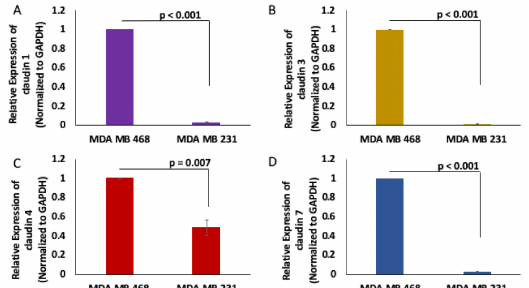
Figure 2. Claudins 1, 3, 4 and 7 expression in MDA MB 468 and MDA MB 231 cells. Claudin 1 ( A ), claudin 3 ( B ), claudin 4 ( C ) and claudin 7 ( D ) expression were assessed using real-time quantitative polymerase chain reaction in MDA MB 231 and MDA MB 468 cell lines; N =